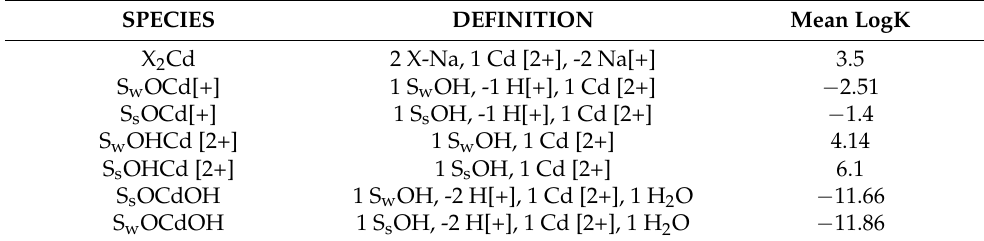
Table 3. Summary of the reactions and mean LogK used for simulating the set of data following the nomenclature of the CHESS code. The constants obtained in each test are detailed in Table S1.